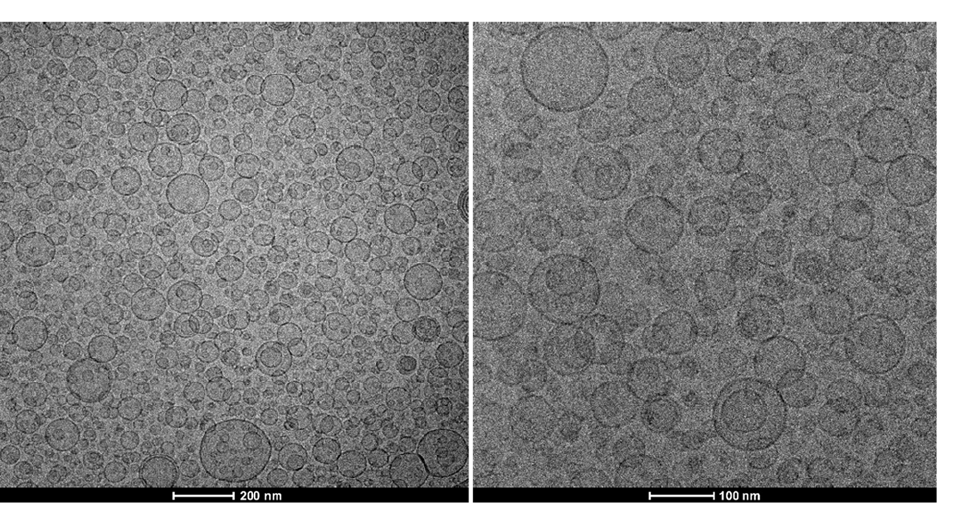
Figure 2. Cryo-TEM images of Tempranillo extract transfersomes. Two magnifications are shown: 29,000× ( left ) and 62,000× ( right ).